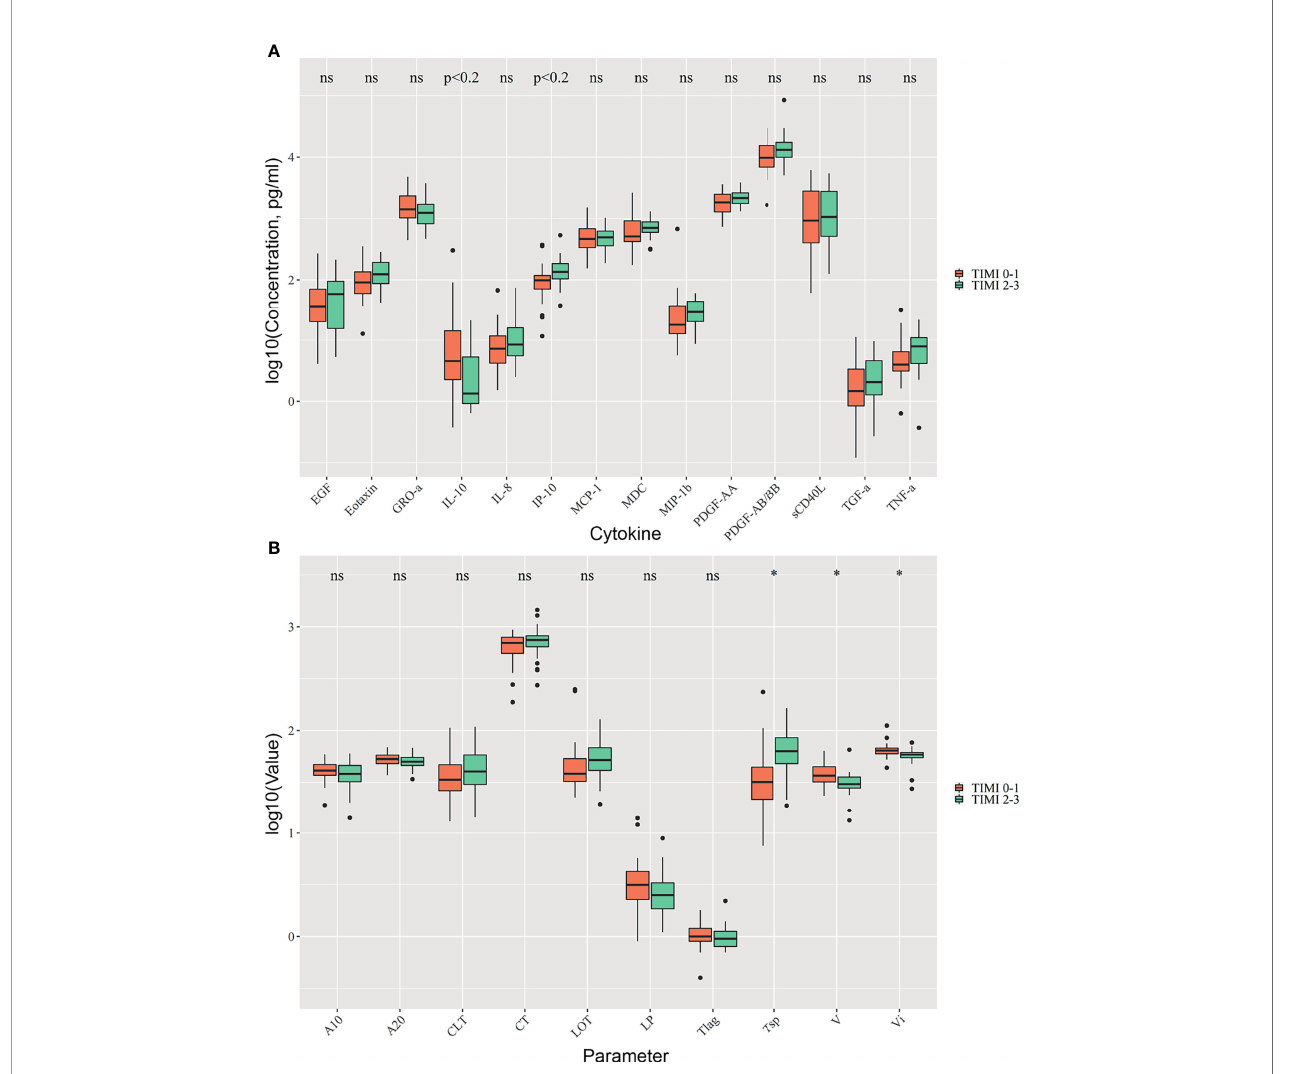
FIGURE 2 | Comparison of TIMI 0-1 and TIMI 2-3 groups. Differences in cytokine concentrations (A) , clot formation and endogenous fi brinolysis (B) . Asterix indicates p-adjusted < 0.05, ns, not signi fi